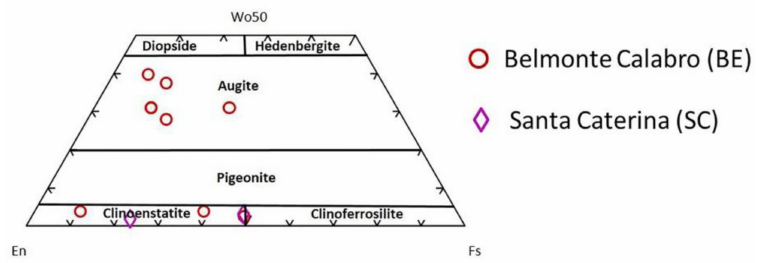
Figure 10. En-Wo-Fs classification diagram for pyroxenes. Analytical data are available in Appendix